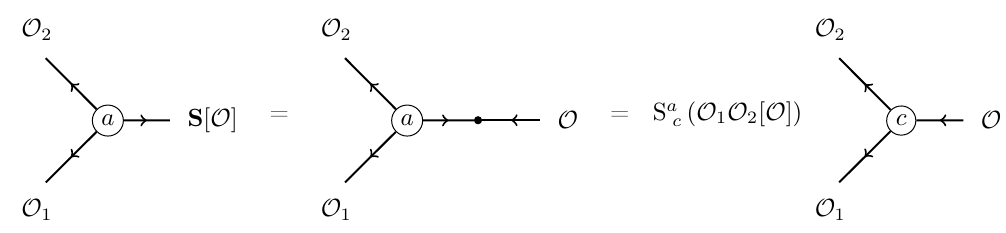
Figure 3 . Diagrammatic de(cid:12)nition of shadow coe(cid:14)cients. Note that a and c label the three- point structures, and arrows allow us to keep track of scaling dimensions. We use the standard convention where an operator with an outgoing arrow from a three-point structure enters that O (cid:1) ;J structure as itself. On the contrary, changing the direction of arrow is equivalent to changing